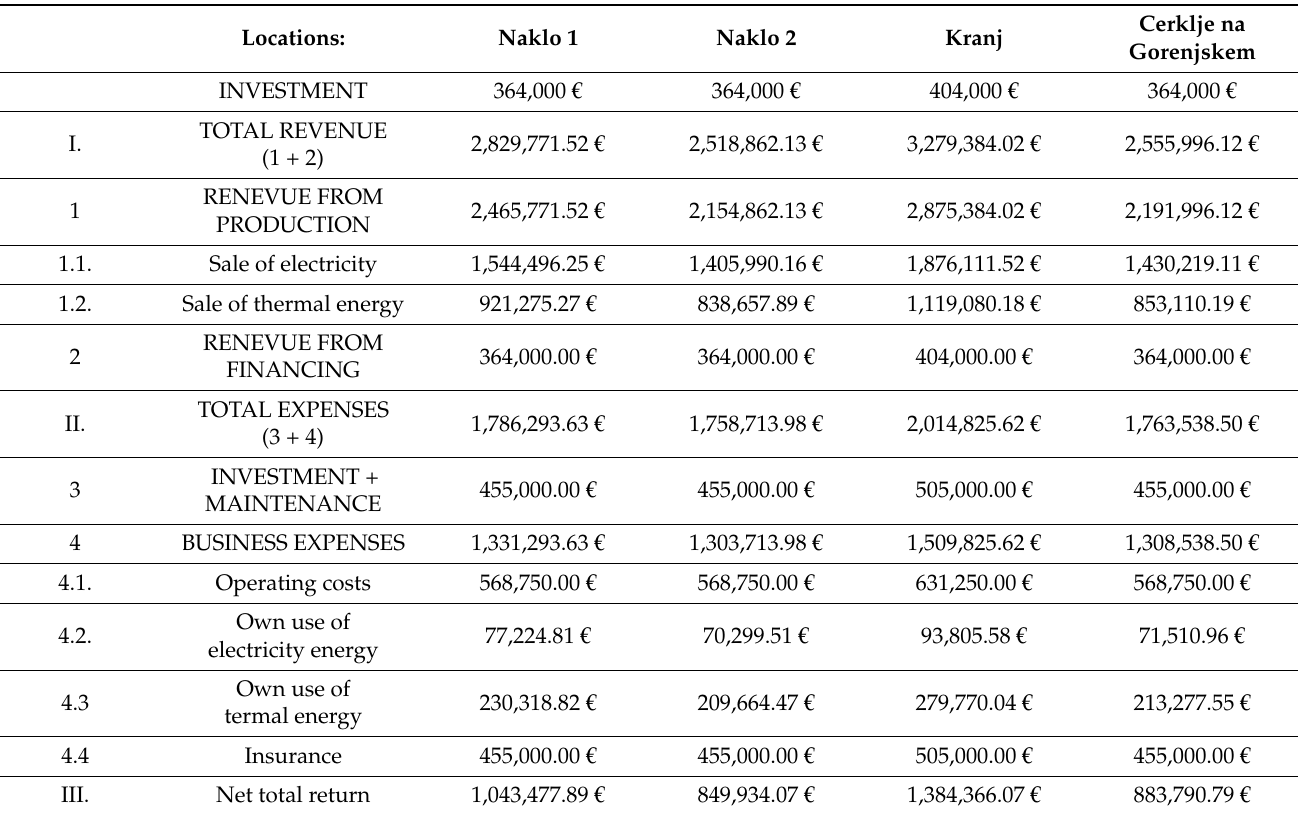
Table 4. Financial calculation of the